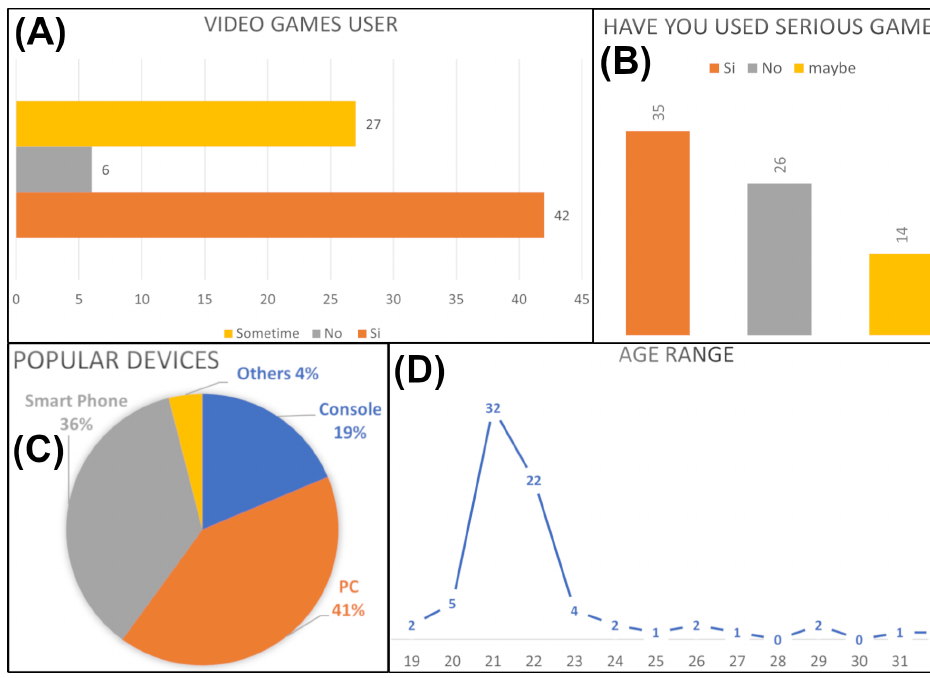
Figure 7. The data from the survey is presented in the graphs below for: ( A ) video game users; ( B ) the number of users who have used a SG; ( C ) the most popular video game devices among our respondents; and ( D ) the age range of the interviewed